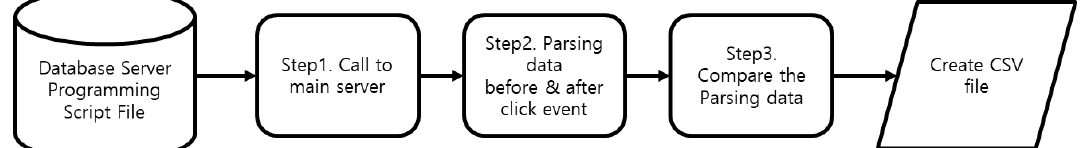
Figure 4. The whole process of collecting data and creating a CSV